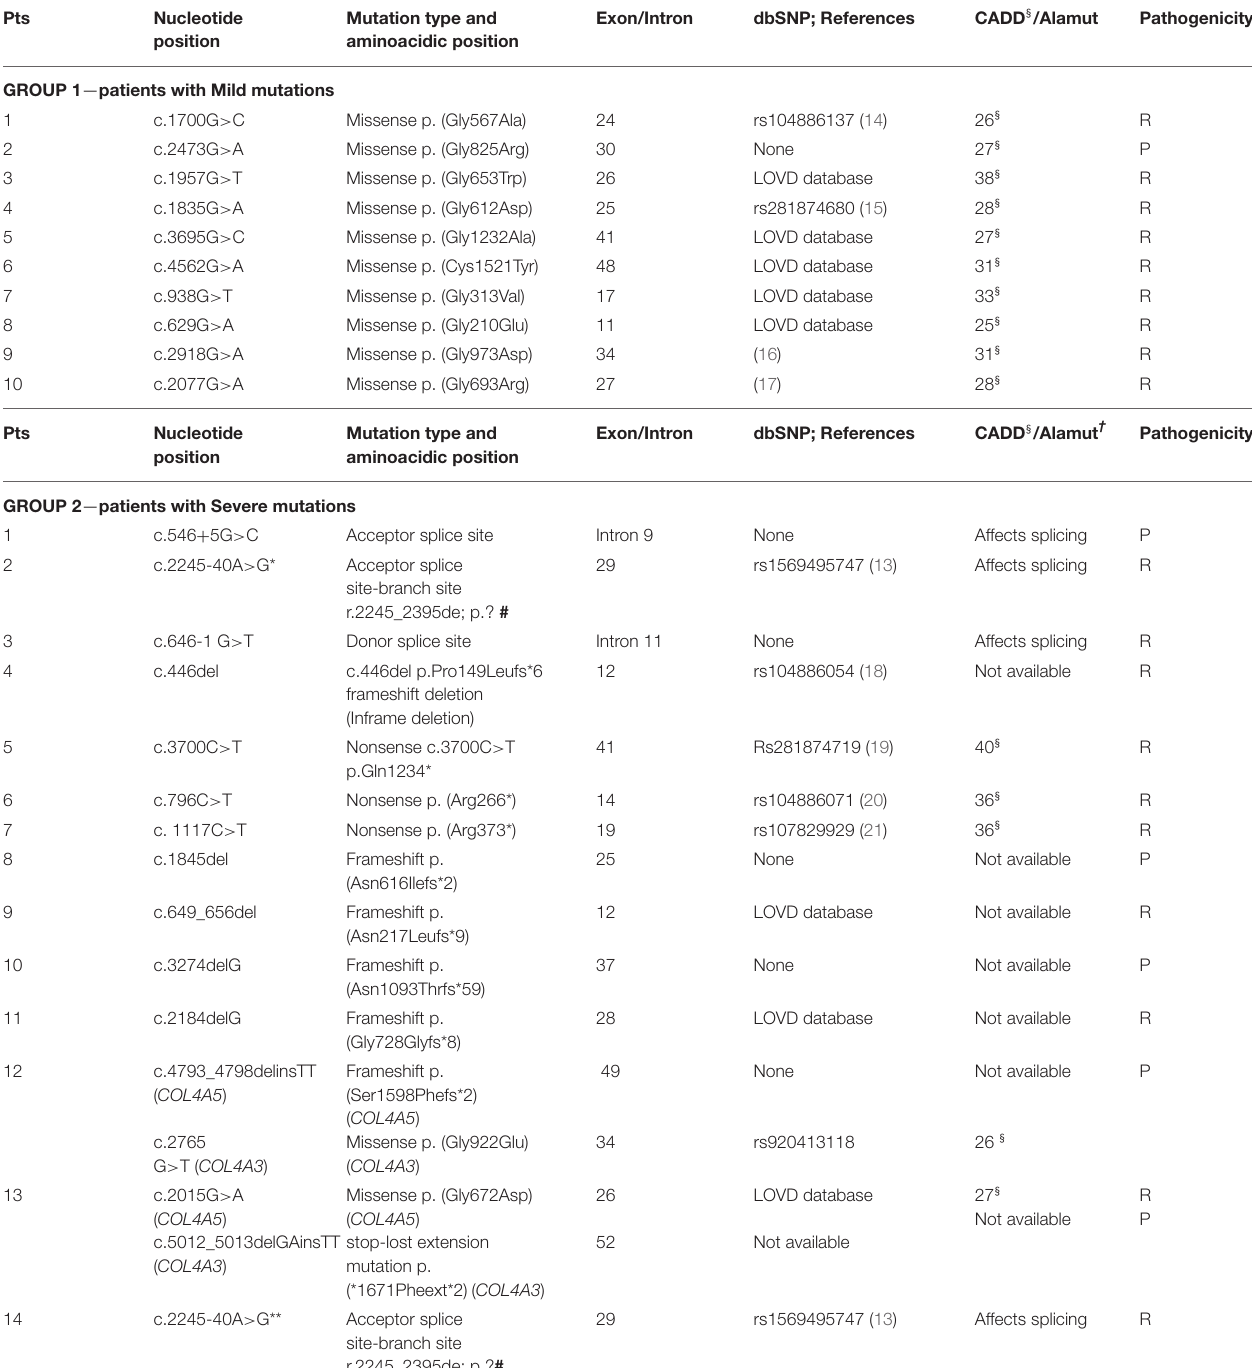
TABLE 2 | Mutations identified in our